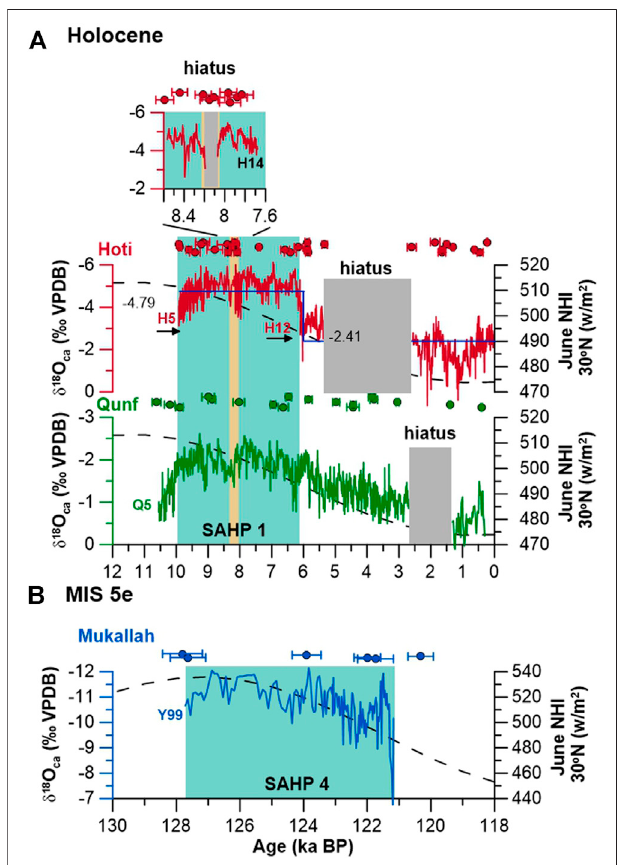
FIGURE 2 | (A) High-resolution δ 18 O ca stalagmite values for the Holocene (H5, H12, H14and Q5). Blue lines for H5 and H12 representmeans before and after the change-point at ∼ 6.2 ka BP. The change-point was identi fi edusingthechangepoint packageforR(Killicket al.,2016). 230 Th ages(cricles)anduncertainty(2 σ )barsaregivenabovetheirrespectivecurves. (B) High-resolution δ 18 O ca stalagmite values for MIS 5e (Y99). 230 Th ages and uncertainties (2 σ ) from Nicholson et al. (2020) (circles) used to create the StalAge (Scholz and Hoffmann, 2011) age-depth model (Nicholson et al.,